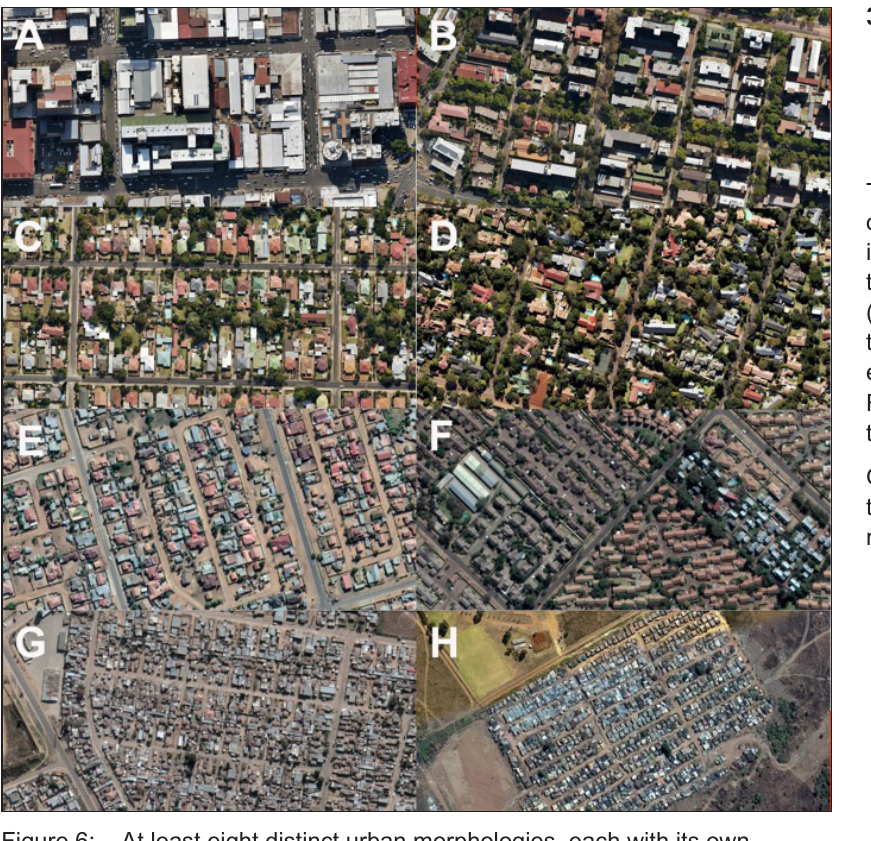
Figure 6: At least eight distinct urban morphologies, each with its own building typologies can be identified in the City of Tshwane metropolitan area. A Pretoria original central core of the city; B Sunnyside; C Capital Park; D Lynnwood; E Soshanguve block JJ; F Equestria; G Olievenhoutbos Ext 21, and H Plastic View informal settlement behind Moreletta Park Dutch Reformed Church. All city portions are at the same scale and north is always at the top. All images created and collated from Google Earth by author. Figure 6 details some of the current morphologies and building typologies found in the city. The street orientations vary significantly, from ideal to very bad from the point of view of passive design and energy efficiency. Depending on the size of Characteristics of the Pretoria urban morphologies as illustrated in Figure 6 (the densities vary drastically) Typical urban morphologies found in the City of Tshwane